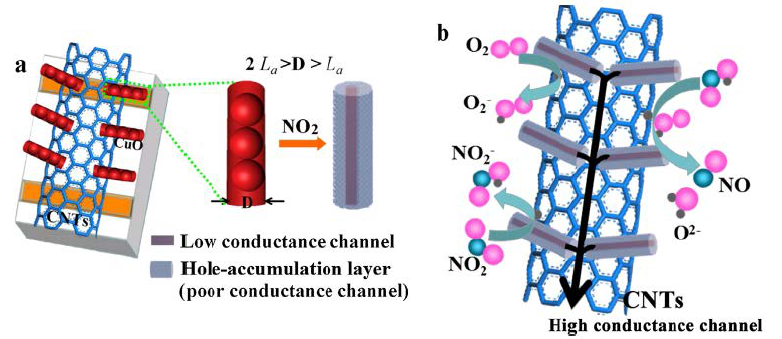
Figure 7. Sensing mechanism of the CuO NR-CNT composite-based sensor: ( a ) the model of CuO NR-CNT composite on the electrode; ( b ) the surface state of CuO NR in a NO 2 atmosphere. Reprinted with permission from [80]. Copyright 2018 Elsevier.